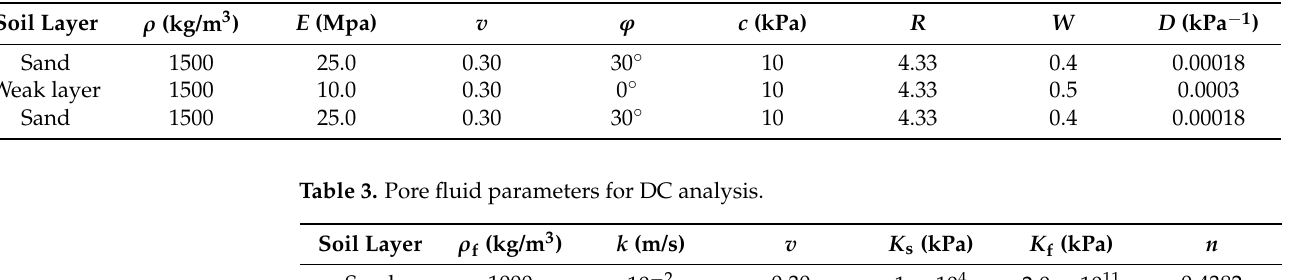
Figure 5. The finite element model of foundation with embedded weak layer. Table 2. Soil parameters for DC analysis.